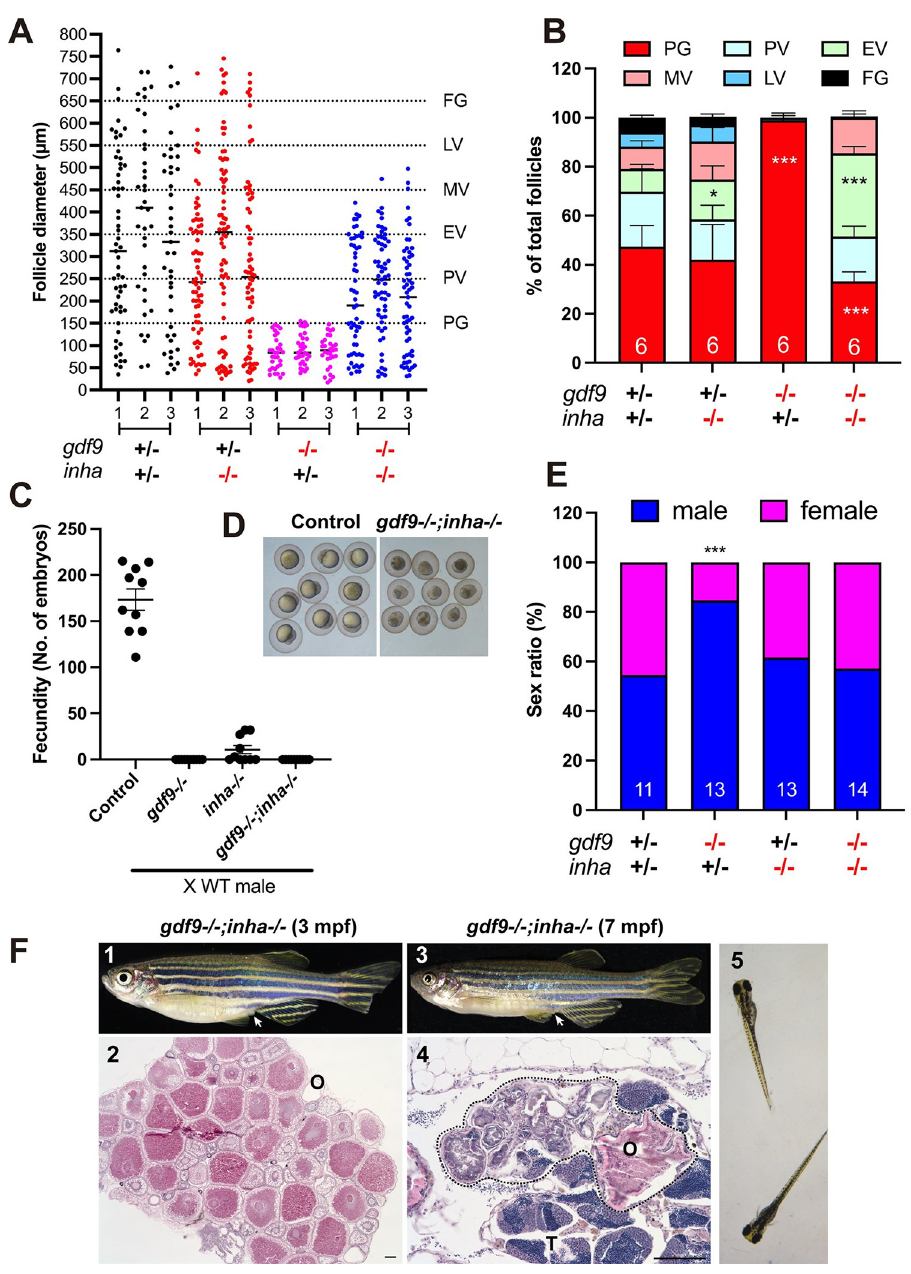
Fig 8. Phenotype analysis of single ( gdf9-/- and inha -/-) and double mutants ( gdf9-/-;inha-/- ). (A and B) Follicle composition in different genotypes at 90 dpf. The follicles in gdf9-/- were arrested at PG stage. Although the PG-PV transition and yolk accumulation resumed in the double mutant ( gdf9-/-;inha-/- ), the vitellogenic growth could not proceed to the FG stage, and the follicles were arrested at the MV-LV transition. � P < 0.05; ��� P < 0.001 (X 2 test, n = 6). (C) Fertility test on females of single ( gdf9-/- and inha-/- ) and double mutants ( gdf9-/-;inha-/- ) at 90 dpf. Five mutant and control females were tested 10 times consecutively every other day by natural pair breeding with WT males (n = 5/test). The test was conducted over about 20 days. In each test, the number of fertilized eggs or embryos was counted for each female and the data point represents the average of the five fish tested. (D) Eggs spawned by the control ( gdf9+/-;inha+/- ) and double mutant ( gdf9-/-;inha-/- ). The eggs from the double mutant were smaller than those from the control. (E) Prevention of sex reversal in gdf9-/- by double mutation with inha -/- at 90 dpf. The gdf9-/- fish showed a male-biased sex ratio (82% males), and this was corrected in the double mutant (47% males). ��� P < 0.001 (X 2 test, n = 11–14). (F) Sex reversal of the gdf9 and inha double mutant ( gdf9-/-;inha-/- ) at 7 mpf. (1) Double mutant female at 3 mpf with female-specific genital papilla (arrow); (2) Ovary of 3-mpf double mutant; (3)